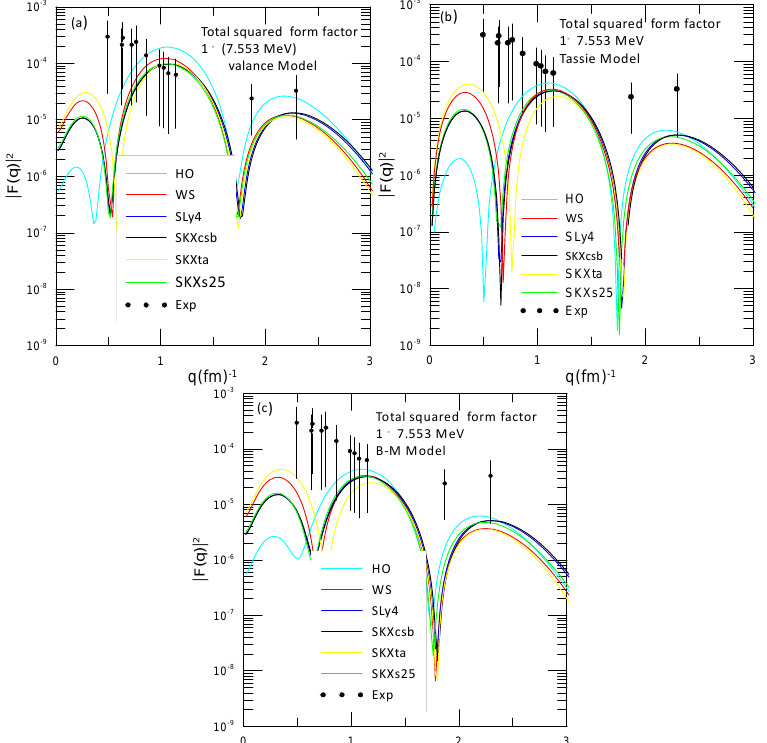
Fig. 8: Total squared form factors for the first 1 - , 7.553 MeV state using different single particle potential compared with the experimental data taken from Ref. [6].